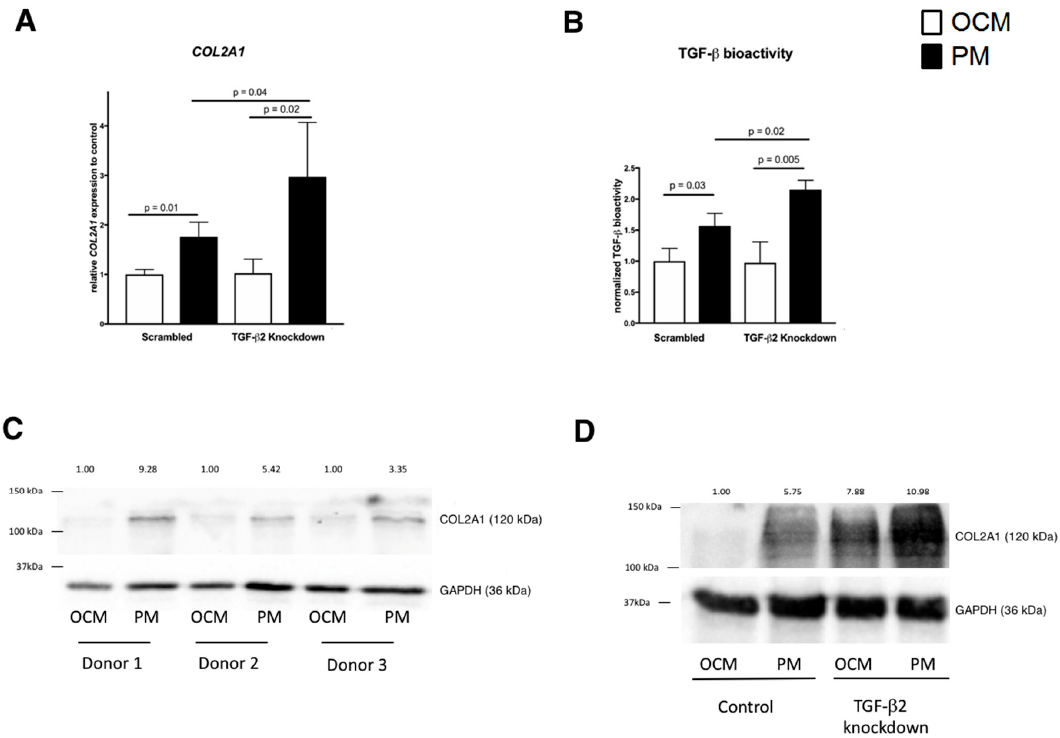
Figure 4. TGF- β 2 RNAi combined with physosmotic treatment increases COL2A1 gene expression and TGF- β bioactivity in HACs. Expression of COL2A1 was measured by RT-qPCR replicates (n = 3) in control conditions ( left ) and after TGF- β 2 RNAi ( right ) in OCM (white bars) or PM (black bar) conditions 48 h after physosmotic stimulation ( A ). TGF- β bioactivity in media from SW1353 cultures with or without TGF- β knockdown from PM and OCM cultures. Data are normalized means ± standard deviation relative to control OCM condition ( B ). Collagen type II (COL2A1) protein expression was confirmed by immunoblotting in HACs from three donors. Molecular weight markers in kDa are shown on the left. The numbers across the top depict the relative quantity ( C , D ).